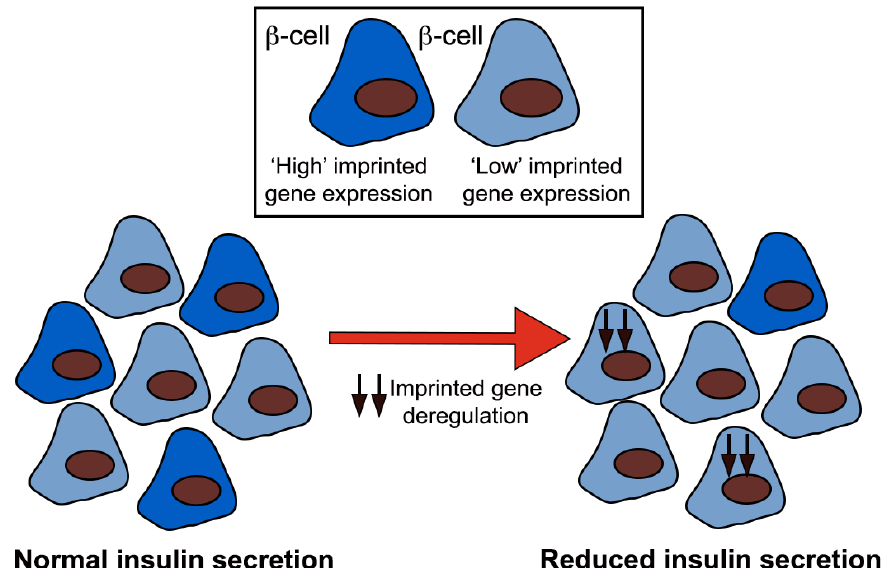
Figure 3. A proposed model for beta cell heterogeneity in terms of imprinted gene expression. Deregulation of imprinted gene expression by environmental factors (i.e., diet) would, in this scenario, reduce beta cell heterogeneity and therefore insulin secretion. Black arrows represent deregulation of imprinted gene